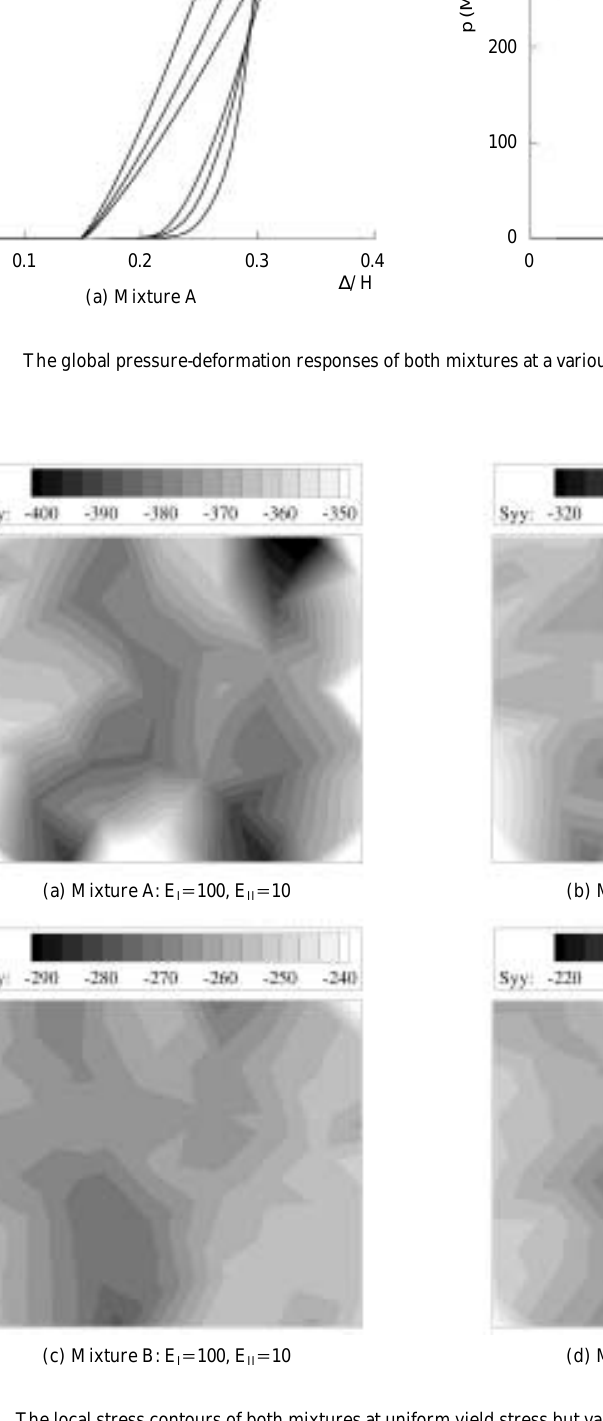
The local stress contours of both mixtures at uniform yield stress but various combinations of